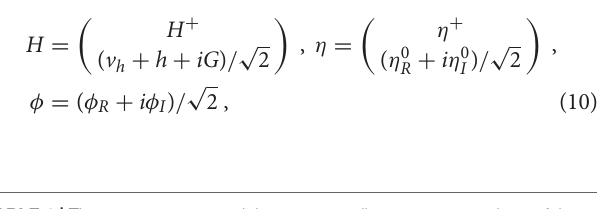
TABLE 1 | The matter content and the corresponding quantum numbers of the model A.